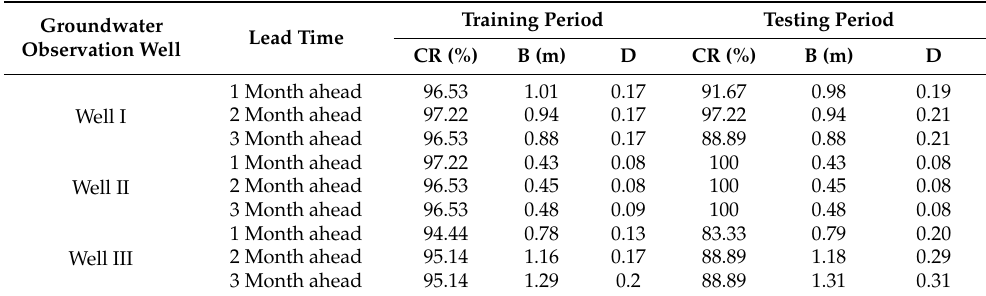
Table 4. Uncertainty analysis of the BMA-predicted GWL for 1-, 2-, and 3-month-ahead horizons for Wells I, II, and III according to the Monte Carlo method during the training and testing